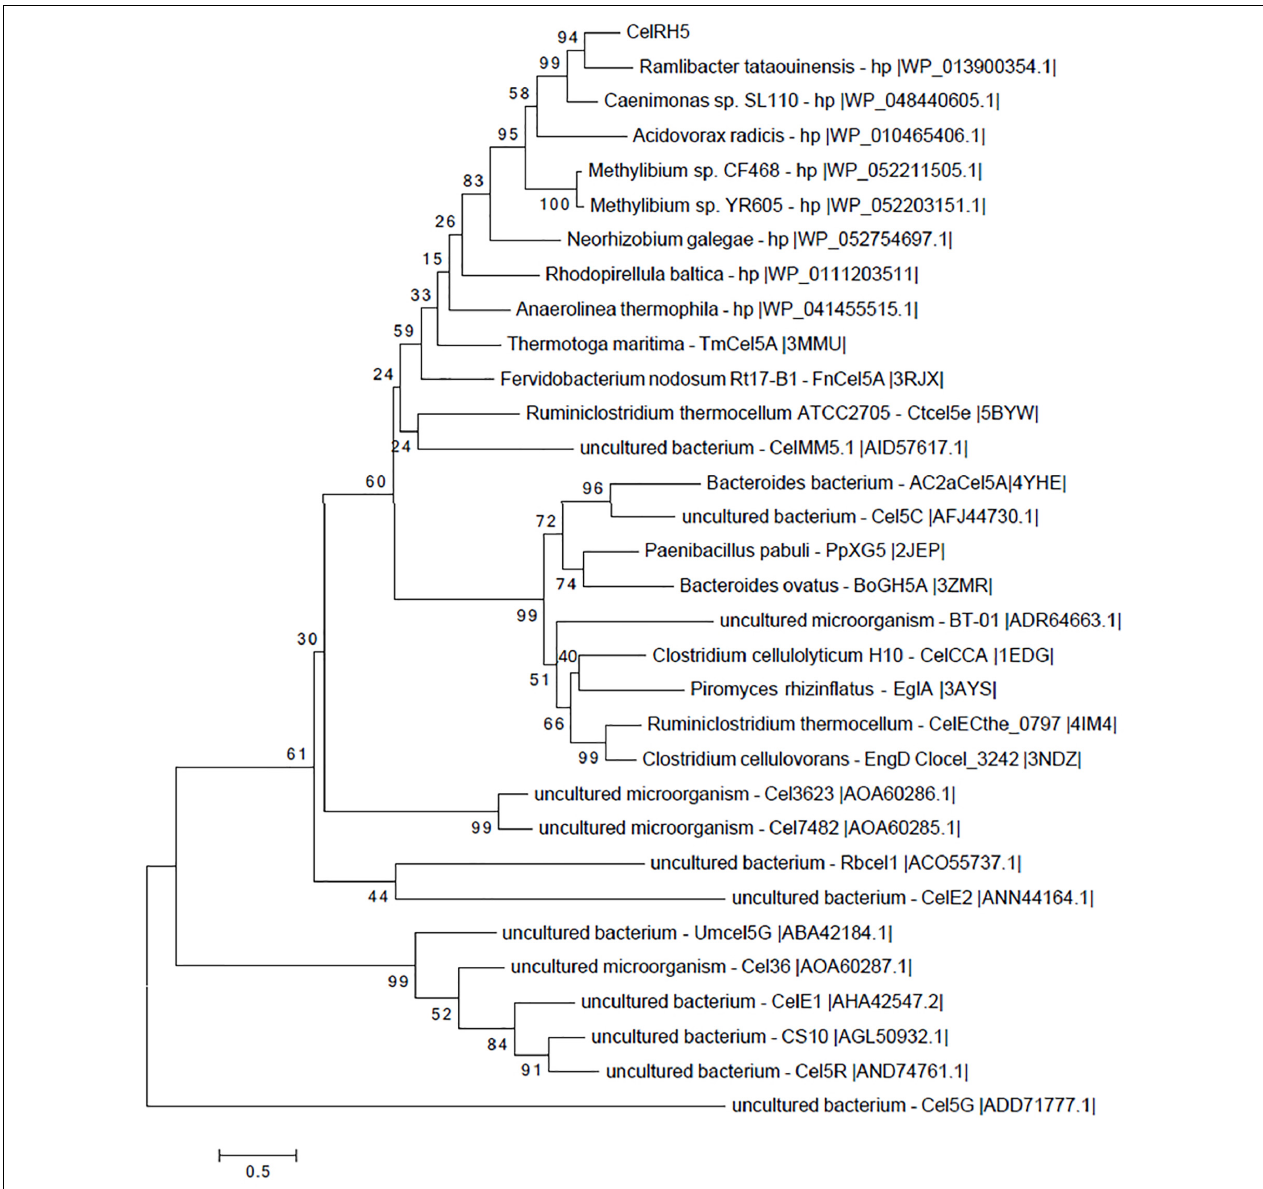
FIGURE 2 | Phylogenetic tree of the CelRH5 amino acid sequence compared to closely related GH5 and other characterized metagenome-derived GH5. Analysis was performed using the MEGA 6.0 application. The tree was constructed using the Maximum Likelihood Method and the LG+G model with bootstrap analysis using 1,000